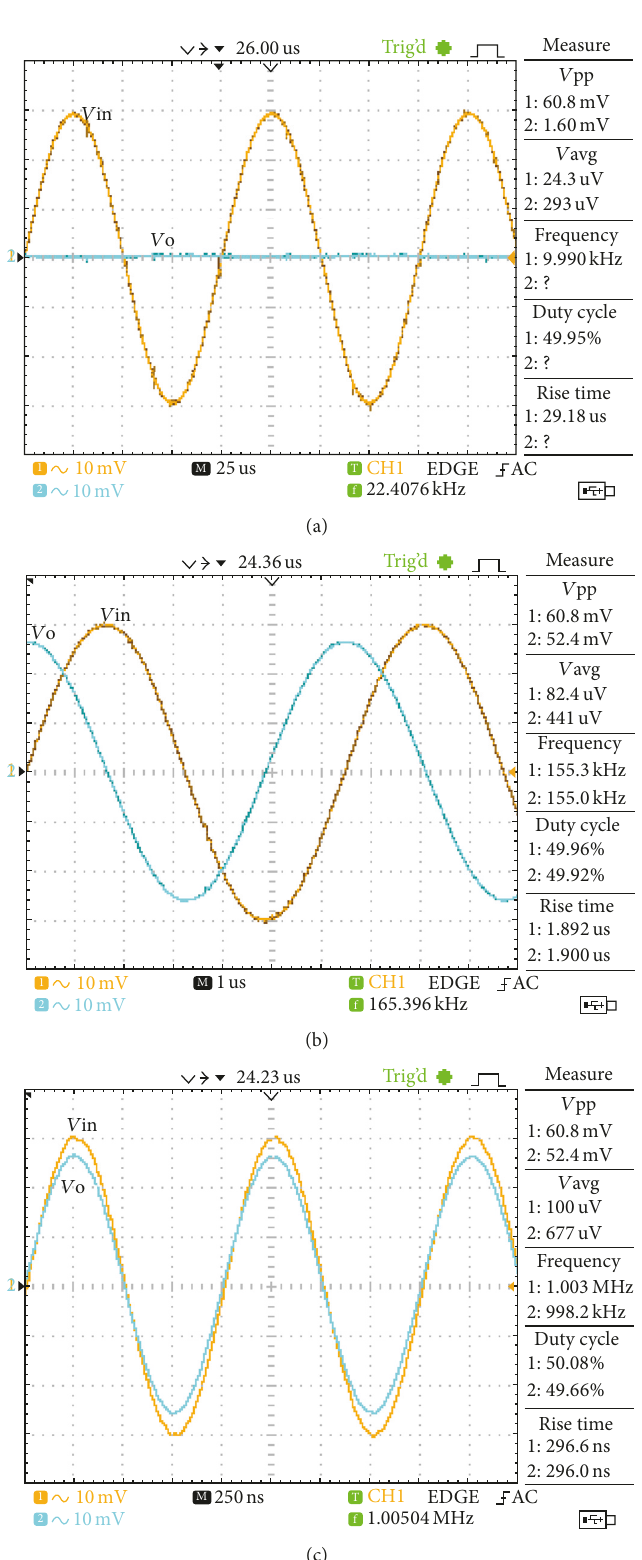
Figure 6: The measured input and output waveforms of high-pass filter at (a) 10kHz, (b) 155 kHz, and (c) 1